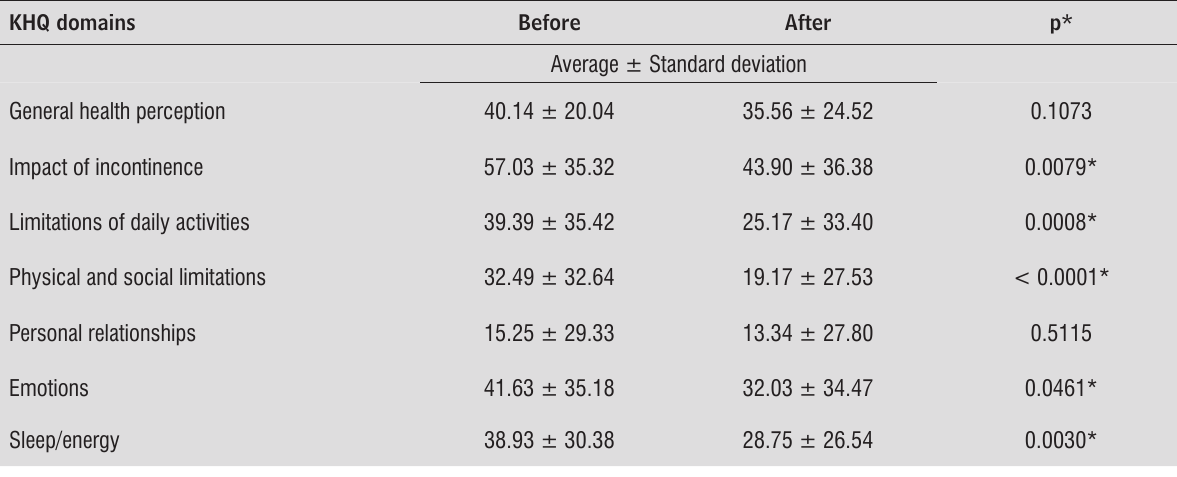
Table 2 - Variations of the domains before and after